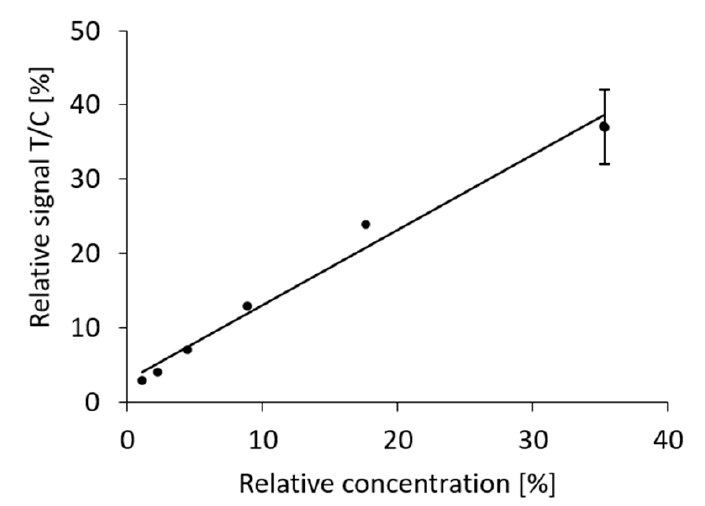
Figure 6. Correlation between antigen concentration after pooling and dilution and the relative sig- nal (intensities test line/control line) observed with PanBio test cassettes. The data was obtained by integration of the signals measured in the dilution series of Table 1 (entries 6 and